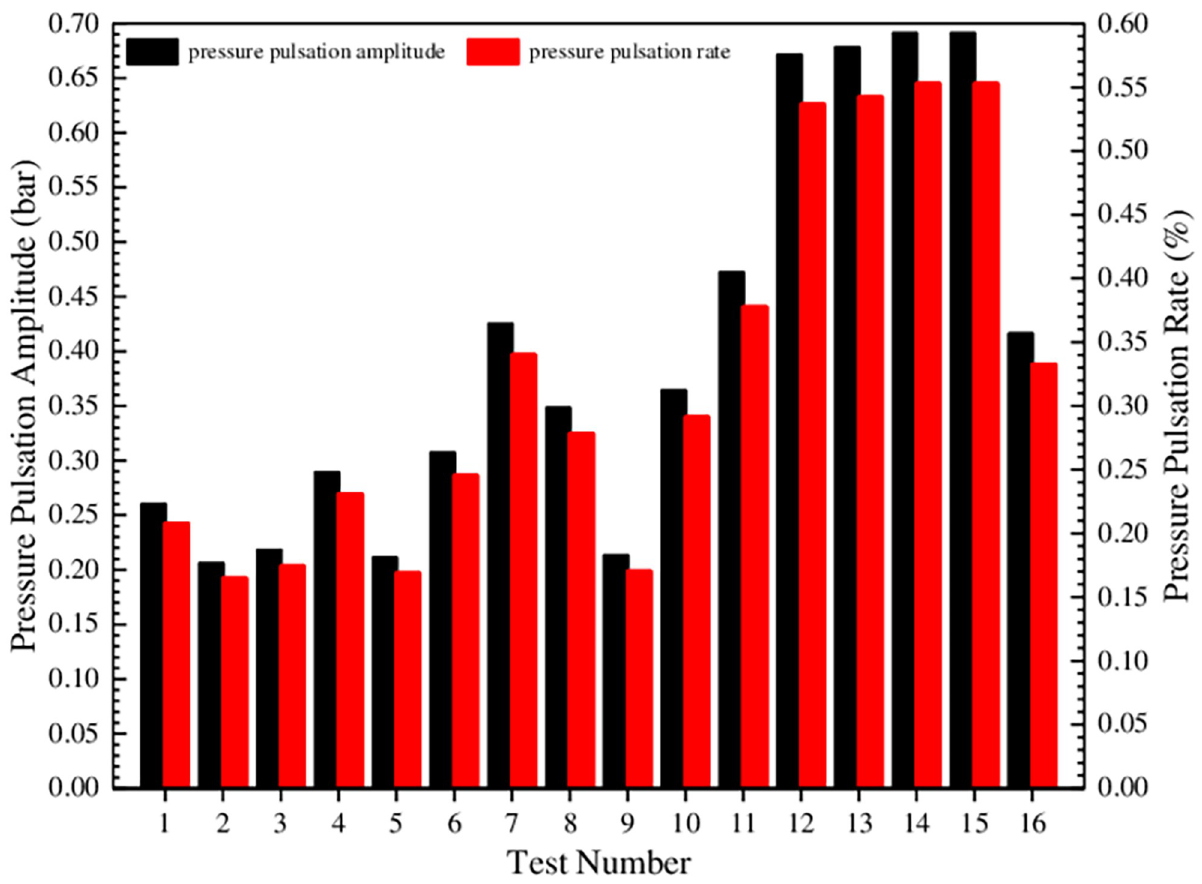
Fig 13. Comparison of pressure pulsation amplitude and pulsation rate under different test conditions.